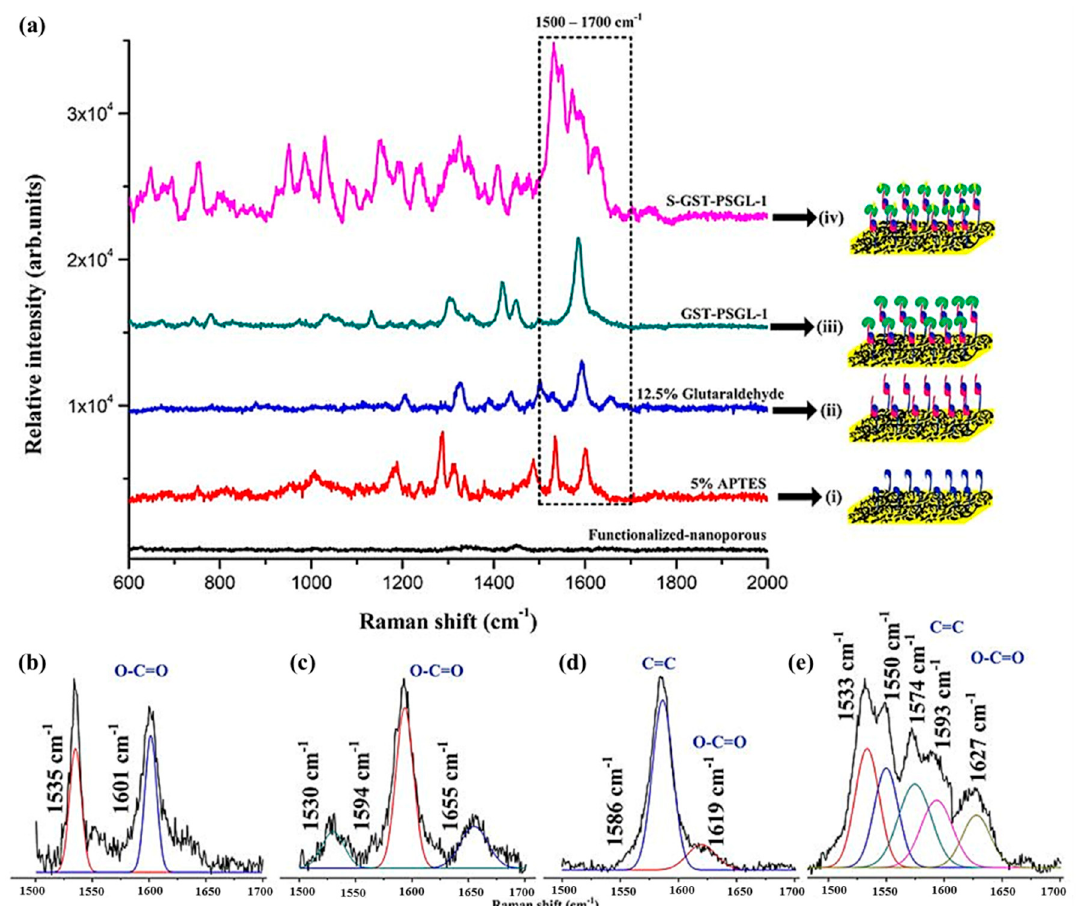
Figure 5. ( a ) The immobilization of protein on the Au nanoplasmonic substrate. An amino group formed on the functionalized Au nanoporous surface was followed by a self-assembled monolayer (SAM) layer, 3-amino-propyltriethoxysilane (APTES)/ethanol solution, and glutaraldehyde. GST-PSGL-1 or S-GST-PSGL-1 was then immobilized on the SAM-modified Au nanoporous surface. At each step, samples were characterized at a Raman laser wavelength of 633 nm. Marked SERS bands at 1500–1700 cm − 1 are highlighted. ( b ) The SERS spectrum of the APTES-modified Au nanoporous substrate shows the O–C=O stretching mode at 1601 cm − 1 . ( c ) The glutaraldehyde-modified substrate SERS spectrum shows strongly shifted O–C=O stretching modes at 1594 and 1655 cm − 1 . ( d , e ) After the PTS reaction, the observed C=C and O–C=O peaks shifted to 1593 and 1627 cm − 1 , respectively.